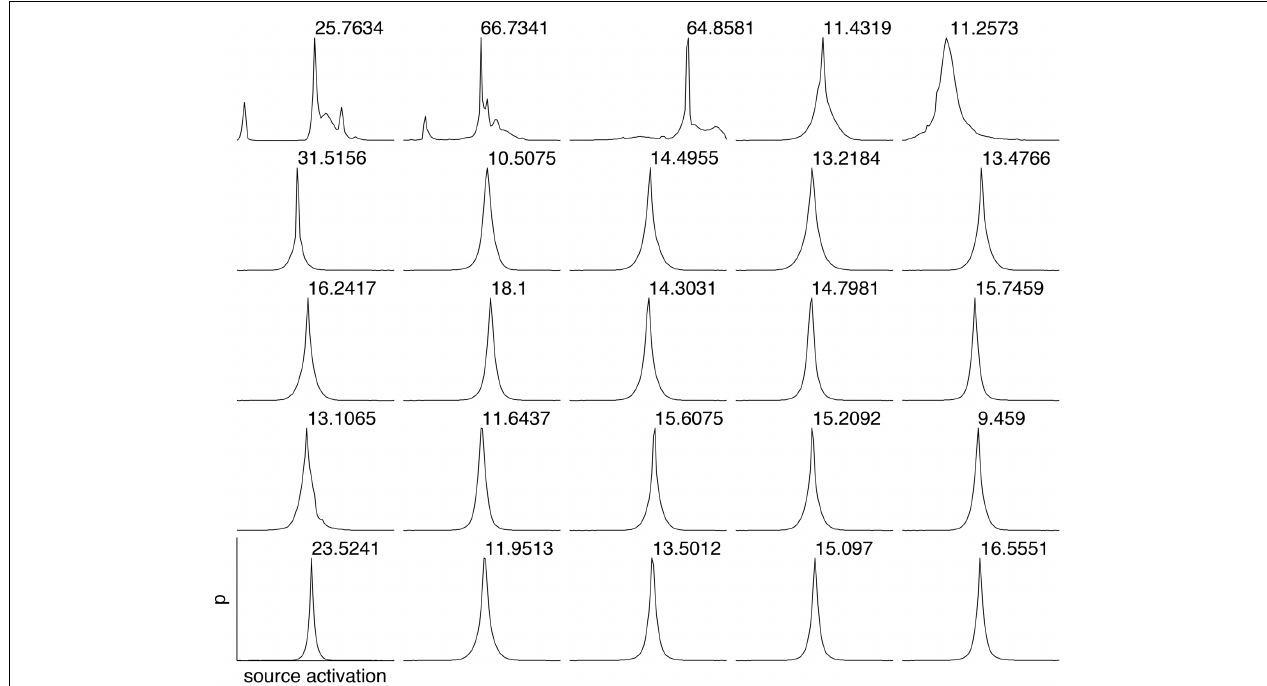
FIGURE 8 | Histograms of the source coefficient values for the first 25 basis functions and the standard kurtosis derived from the source coefficients.